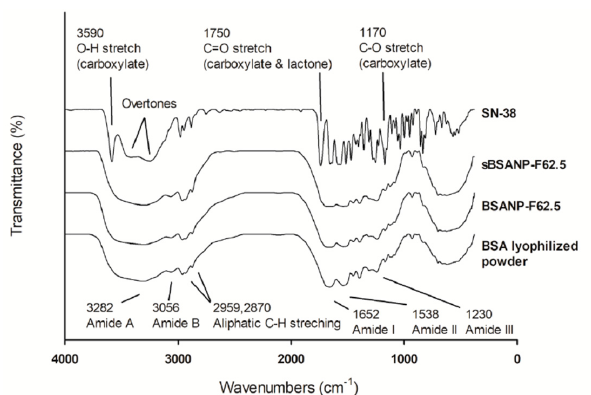
Figure 3. FTIR spectrum of SN-38, sBSANP, BSANP, and BSA lyophilized powder. Abbreviations: FTIR (Fourier-transform infrared spectroscopy); sBSANP (SN-38-loaded bovine serum albumin nanoparticle); BSANP (empty bovine serum albumin nanoparticle).